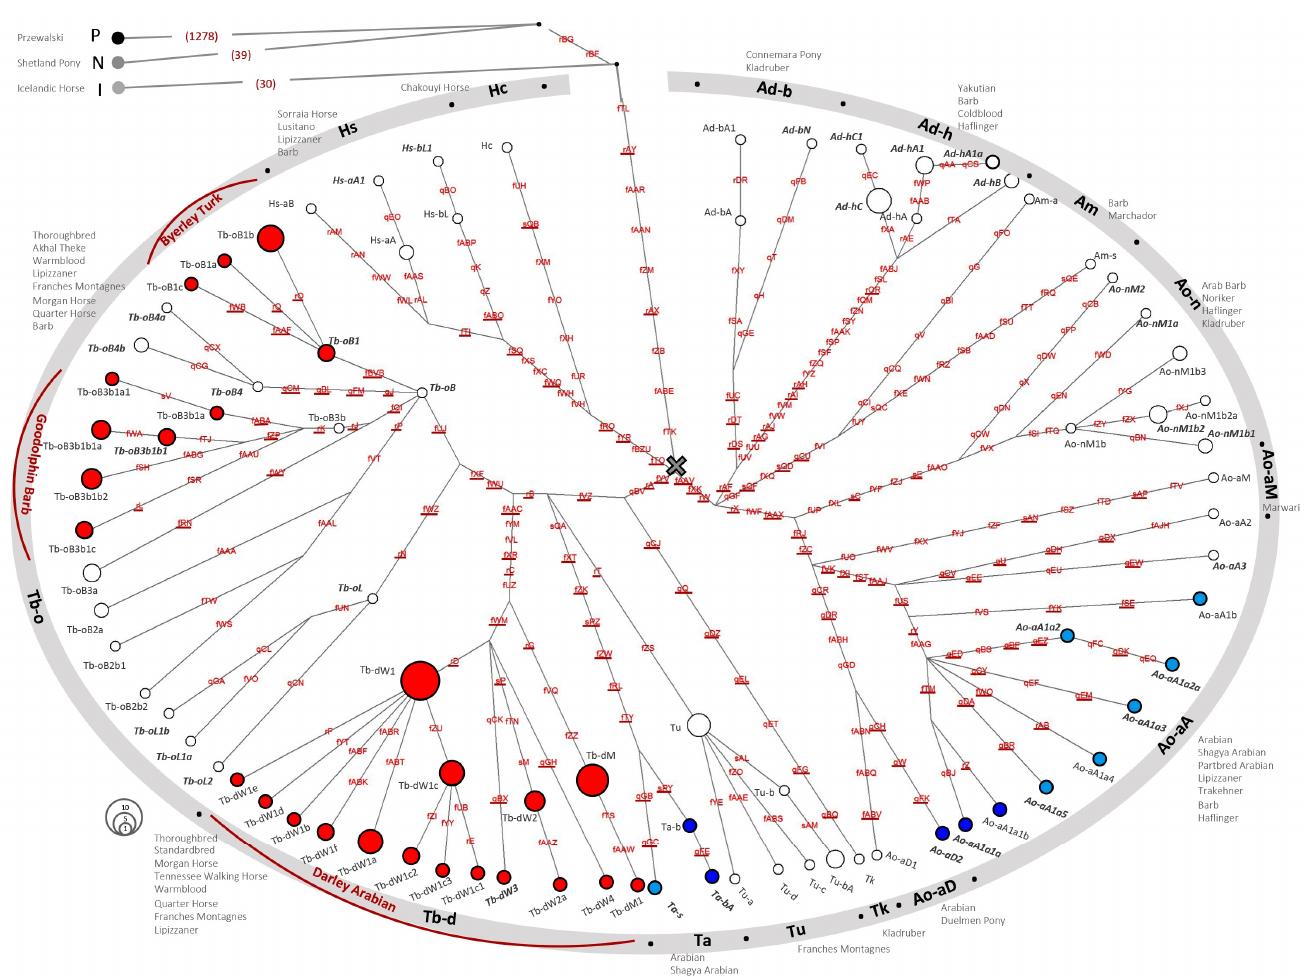
Figure 1. NGS HT Network. The MSY HT network from 118 WGS sequenced males and 39 TES males, based on a total of 1,639 variants (281 crown, 1,358 outside the crown). HTs are indicated as circles, with circle size being proportional to frequency. HT-IDs and sample information are provided in Table S1. HTs first described in this study based on TES data are shown in bold. Variants are indicated on branches and underlined when selected for genotyping. The position of the crown MRCA is marked with a cross. The 14 crown HGs are indicated in the outer circle, with the breeds listed beside them. Blue HTs were detected in Arabians, and light blue HTs were detected in a horse that traced back to an imported Arabian in the paternal lineage. The signatures of the three founders of the English Thoroughbred (Tb-oB1, Tb-oB31, and Tb-d) are marked with red lines.